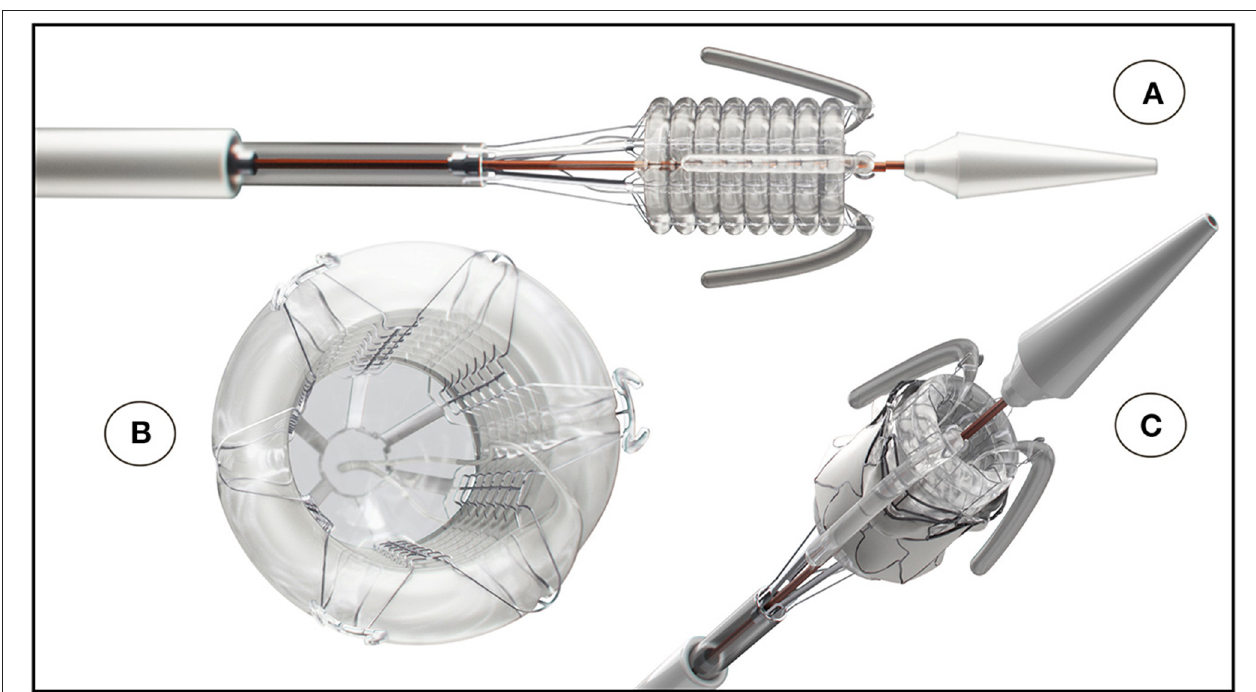
FIGURE 10 | The SAT non-occlusive balloon-delivery system consisting of a helical balloon is prevented from toppling by a Nitinol frame; (B) positioning- and stabilizer-trunks that are invaginating upon retraction; (A,C) a back-flow valve and (B) a pressurized rolling sleeve for device retrieval [ (A) Reproduced from ( 31) with